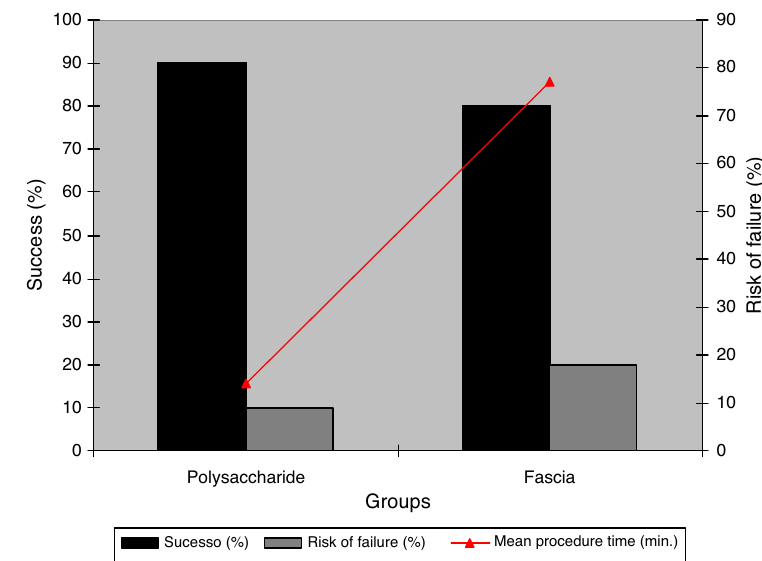
Figure 4 Relationship between material’s success and failure versus procedure